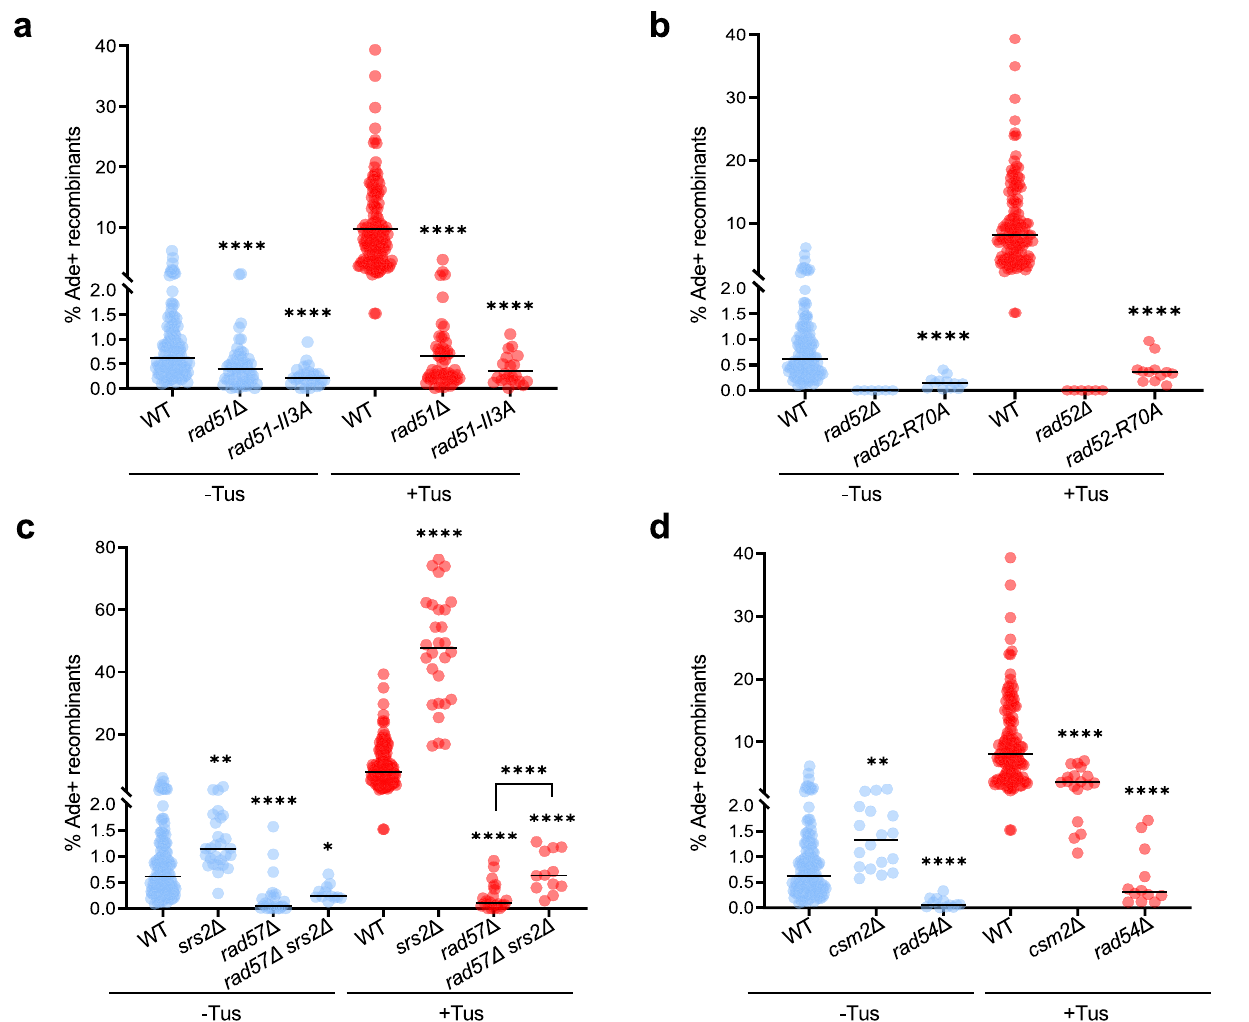
Fig. 3 Rad51 strand invasion, Rad52 strand annealing, and recombination mediators are required for Tus/ Ter -induced NAHR. a Ade + recombination frequencies for WT and rad51 mutant strains containing 14 Ter repeats in the blocking orientation. b Ade + recombination frequencies in WT and rad52 mutant strains containing 14 Ter repeats in the blocking orientation. c Ade + recombination frequencies in WT, srs2 Δ and rad57 Δ single and double mutant strains containing 14 Ter repeats in the blocking orientation. d Ade + recombinants frequencies in WT, cms2 Δ and rad54 Δ mutant strains containing 14 Ter repeats in the blocking orientation. a – d Black lines indicate medians. The numbers of colonies tested for each strain are reported in Supplementary Table 1. p -values were obtained on log-transformed data by one-way ANOVA with a Bonferroni post-test and are relative to the WT strain in the same condition. They are reported as stars when signi fi cant with: * p -value < 0.05, ** p -value < 0.005, *** p -value < 0.001, **** p -value < 0.0001. Source data are provided as a Source Data fi le and exact p -values are reported in Supplementary Data